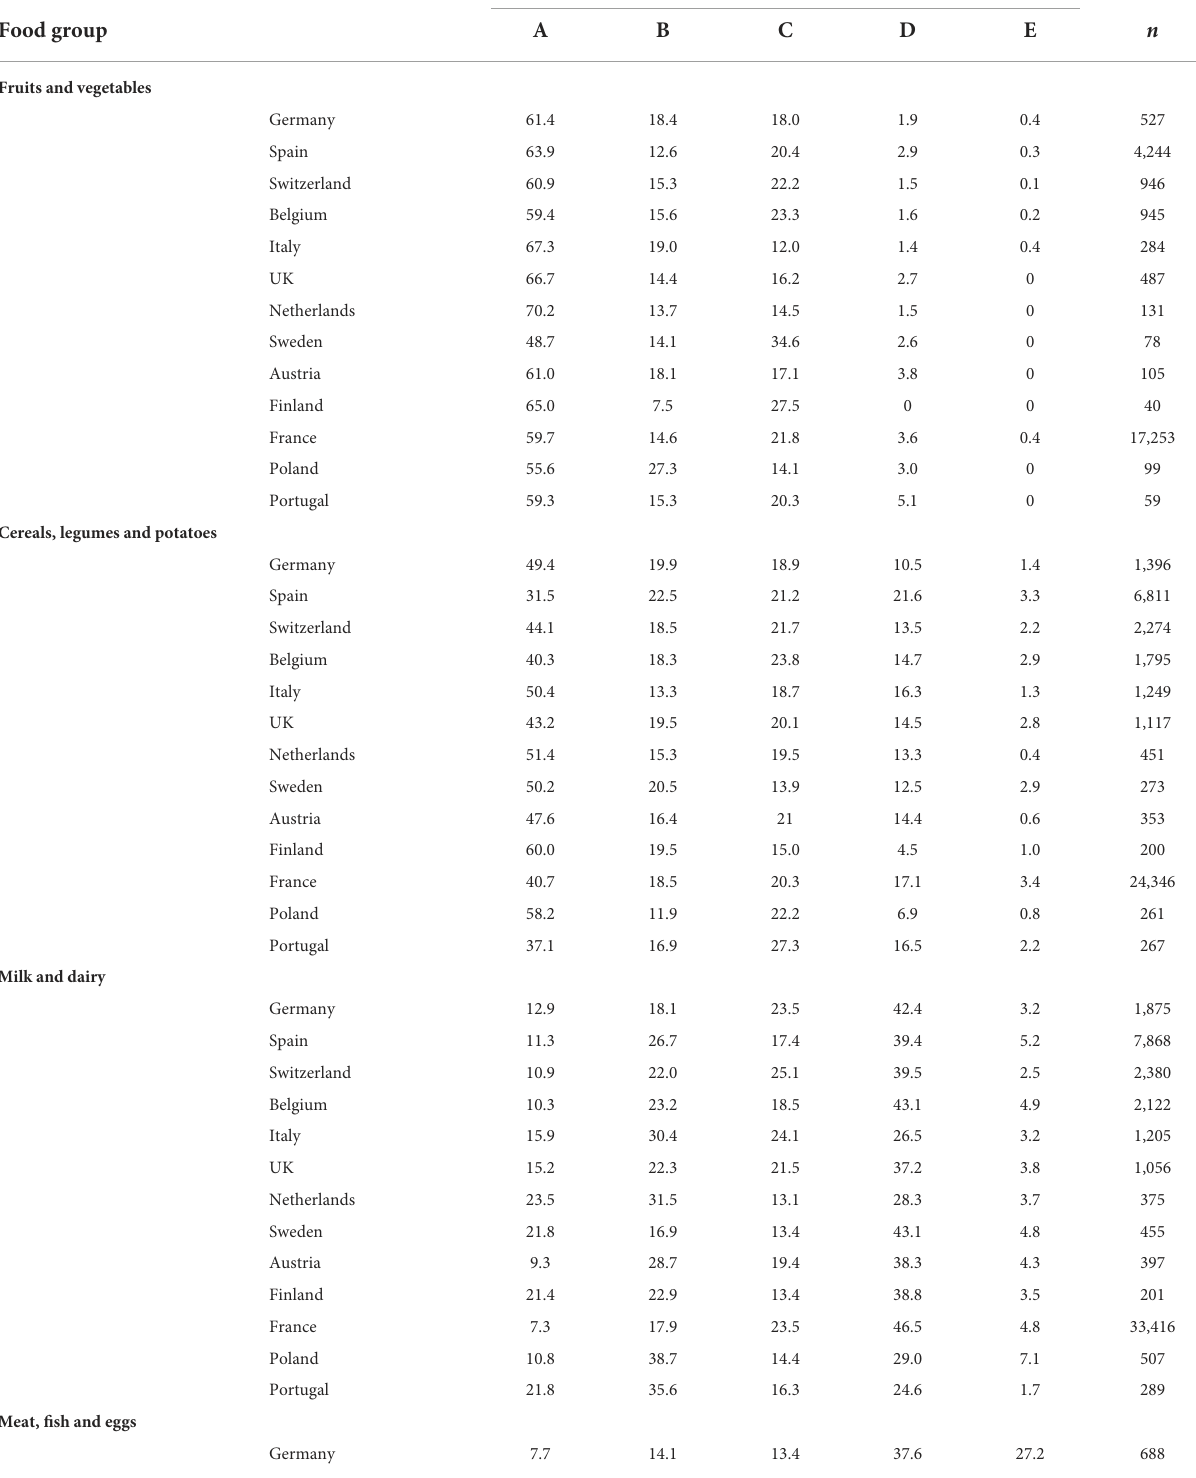
TABLE 5 Country-specific distributions (%) a,b of food groups across Nutri-Score classes as reported for Germany in Szabo et al. (36) and for Spain, Switzerland, Belgium, Italy, UK, The Netherlands, Sweden, Austria, Finland, France, Poland and Portugal in Szabo et al. (39) *